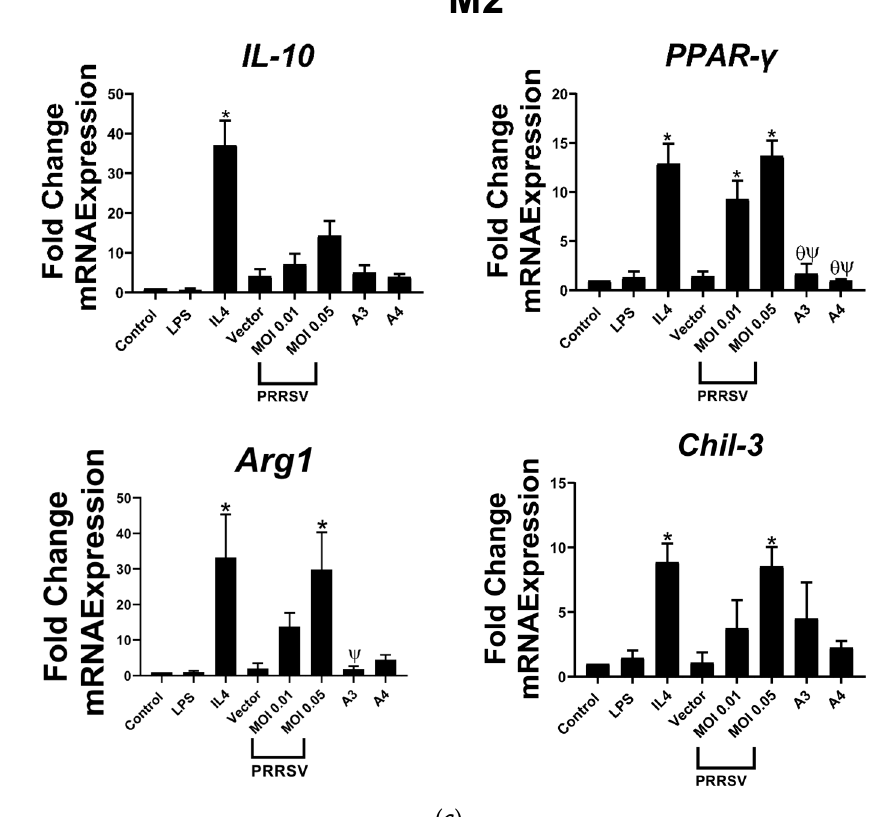
Figure 2. The antigen A3 decreased the expression of CD163 in PAMs and drove M1 macrophage polarization. ( a ) A3 decreased the expression of CD163 in PAMs. Untreated PAMs were used as control. The mRNA expression profile of ( b ) M1 and ( c ) M2 subtypes of PAMs measured by quantitative PCR (qPCR). A3 promoted upregulation of proinflammatory genes (M1 phenotypes) and downregulation of anti-inflammatory genes (M2 phenotypes). * p < 0.05 compared to control group, θ p < 0.05 compared to 0.01 MOI, ψ p < 0.05 compared to 0.05 MOI. Data presented as means ± SEM, calculated from 4 pigs.